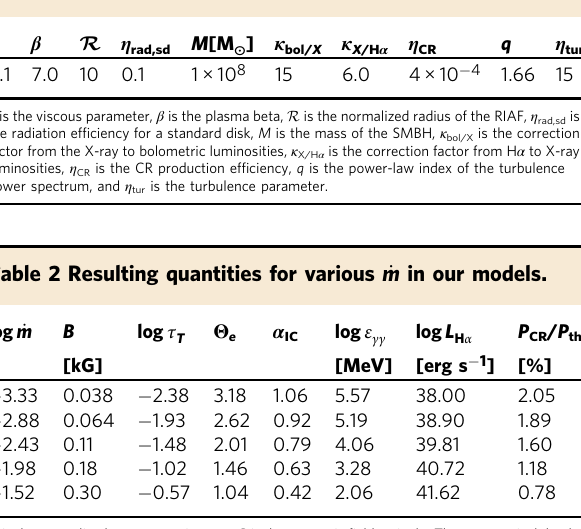
Owing to the strong Θ e dependence, our model predicts RIAF electron temperatures which lie in a narrow range Θ e ~ 1 − 3, unavoidably leading to a peak in the MeV range for _ m ≳ 2 ´ 10 (cid:3) 3 . The normalization is determined by the balance with the Table 1 Model parameters in our reference model.